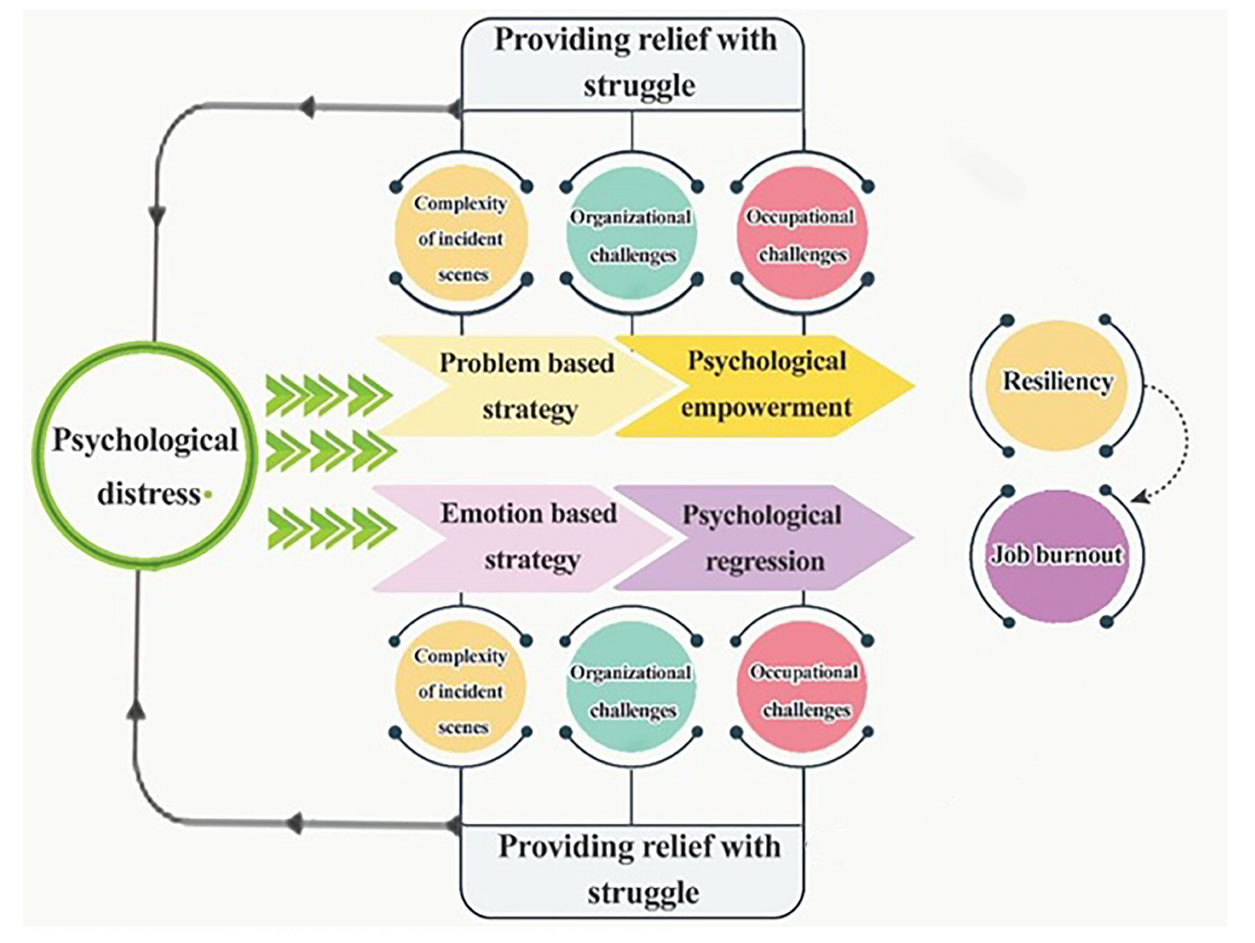
FIGURE 1 | Psychological distress